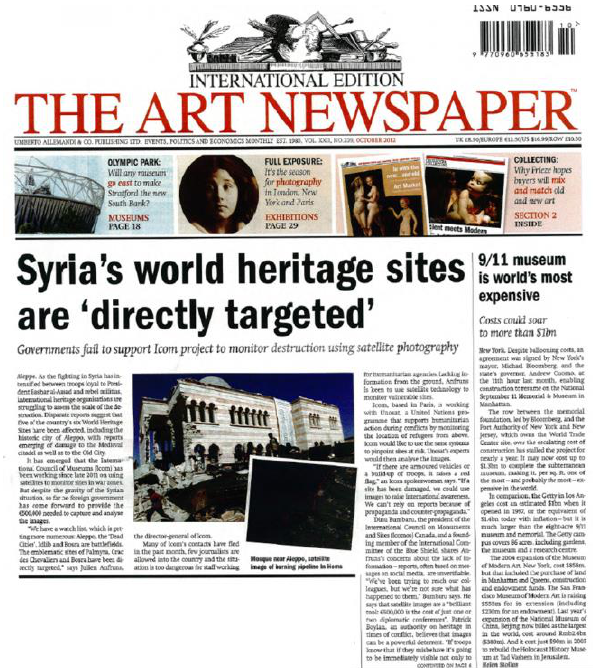
Figure 1. Documentation for cultural heritage sites at risk also includes collecting secondary sources of information from newspapers, social media and other digital